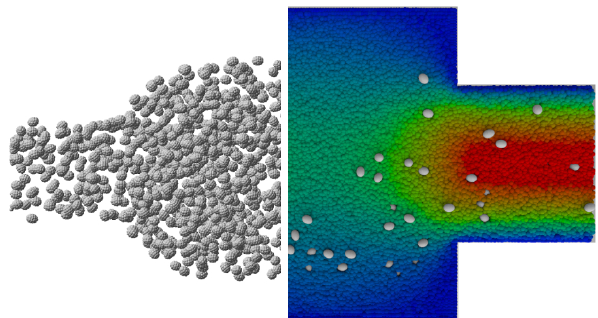
Figure 20. Simulation of rigid bodies inside a fluid flow: rigid el- lipsoids with their BCE markers are shown in the left image while the fluid’s velocity contours and rigid ellipsoids at the mid-section of the channel are shown in the right image.